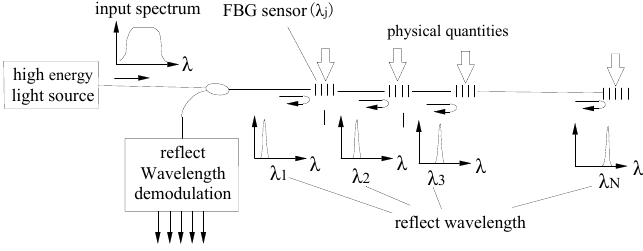
Figure 1. Schematic showing the basic principle of fiber Bragg grating (FBG)-based monitoring sensors.